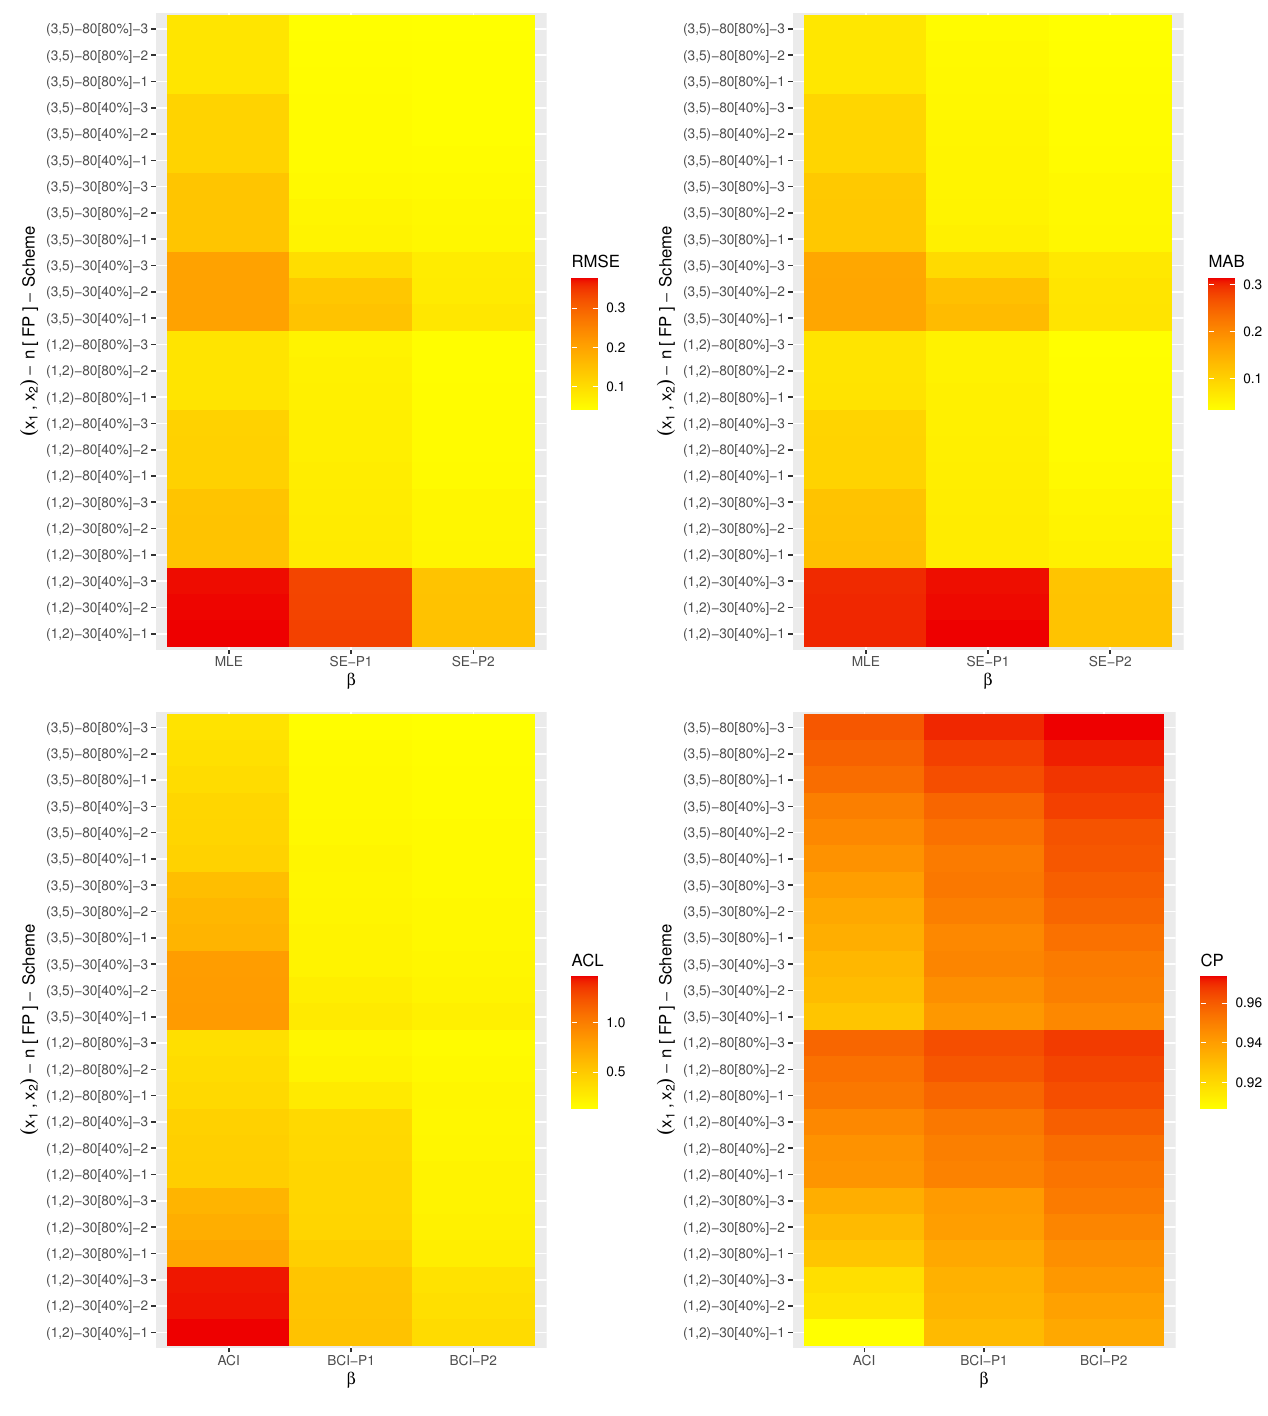
Figure 3. Heat map for the simulation results of β